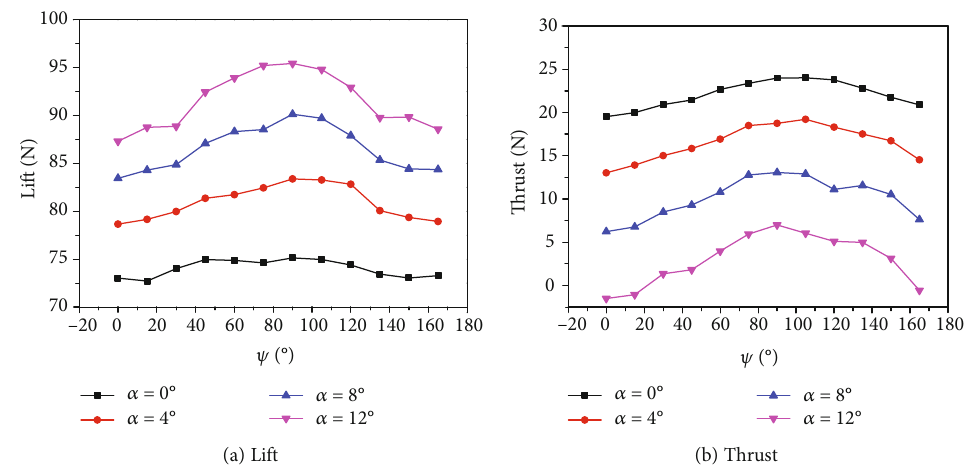
Figure 6: The variation curve of installation angle of a single leading edge winglet with angle of attack ( v = 12 m/s).